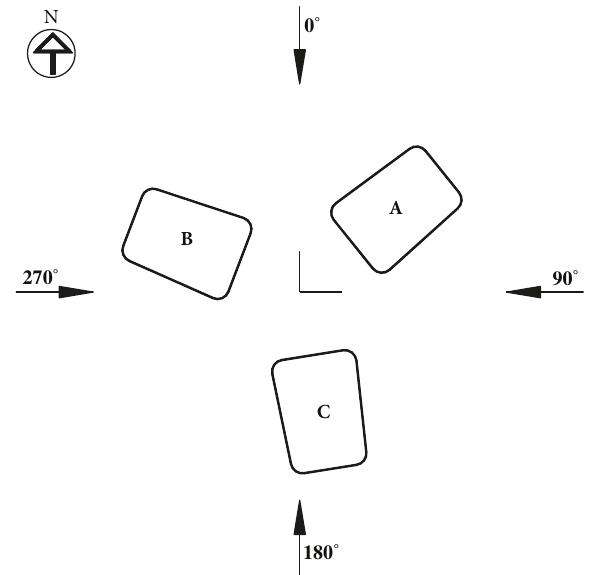
Figure 4: Schematic of the wind